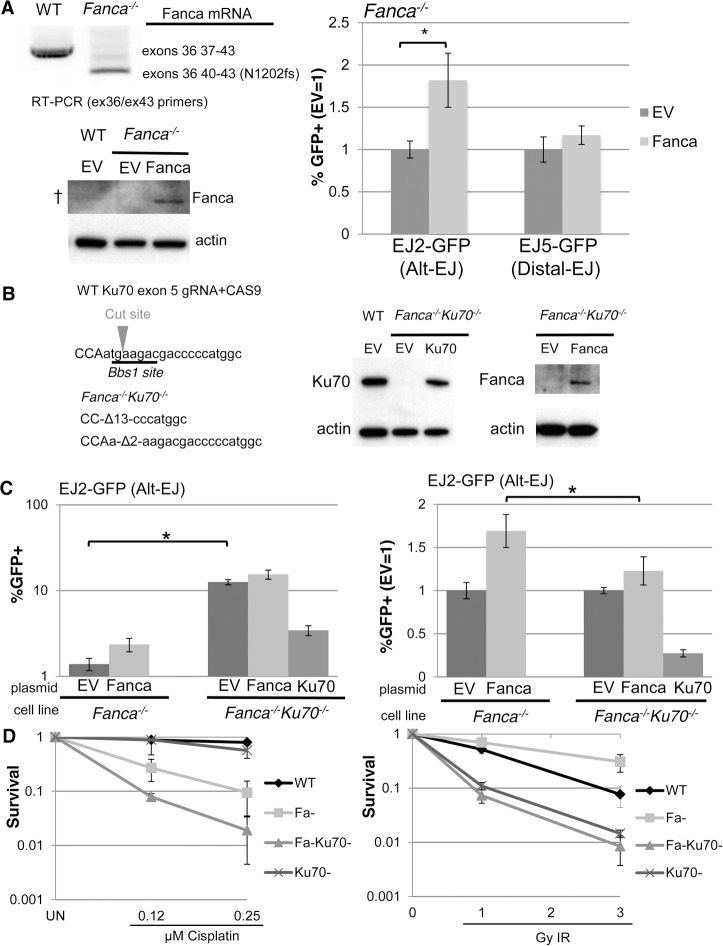
Loss of Ku70 can diminish the influence of Fanca on Alt-EJ, but not cisplatin sensitivity.(A) Transient expression of Fanca in Fanca−/− mES cells promotes Alt-EJ but not Distal-EJ. The EJ2-GFP and EJ5-GFP reporters were integrated into Fanca−/− mES cells. Shown are RT-PCR signals confirming the exon 37–39 deletion in Fanca−/−, which causes a frame shift at N1202. These cells were transfected with expression vectors for I-SceI along with either mouse Fanca or empty vector (EV). Repair values (%GFP+) from these transfections are shown relative to parallel EV. *P<0.0001 (n = 9). Also shown are immunoblot signals detecting expression of Fanca from cells transfected with the expression vector, although this anti-human FANCA antibody is unable to detect endogenous Fanca in WT (†). (B) Generation of Ku70 frame-shift mutations in Fanca−/− EJ2-GFP mES cells. Shown is the predicted target cut site in Ku70 exon 5 for a guide RNA and CAS9, along with sequence of the Ku70 frame-shift mutations (13 and 2 nt deletions, Δ13 and Δ2, respectively) that resulted from two rounds of CAS9 expression. Shown are immunoblot signals of these Fanca−/−Ku70−/− mES cells for Ku70 and Fanca, following transient transfection with Ku70 or Fanca expression vectors, respectively. (C) Loss of Ku70 diminishes the influence of Fanca on Alt-EJ. The Fanca−/− and Fanca−/−Ku70−/− EJ2-GFP cell lines were co-transfected with Fanca, Ku70, or EV and I-SceI expression vectors. Shown are %GFP+ frequencies normalized to transfected cells using transfection with a GFP expression vector in parallel. *P<0.0001 (n = 11). On the right are the fold changes in GFP+ frequencies relative to EV. *P<0.0001 (n = 11). (D) Loss of Ku70 causes cisplatin and IR hypersensitivity in Fanca-/- cells. WT, Fanca−/−, Fanca−/−Ku70−/−, and Ku70−/− mES cell lines were treated continually with cisplatin, or exposed to IR (Cs137), and cultured to allow colony formation. Shown is fraction clonogenic survival relative to untreated cells (UN).